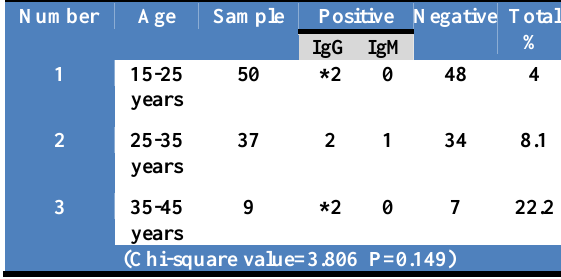
Table, 1: Differences between proportions (IgG, IgM and total) of Toxoplasmosis in